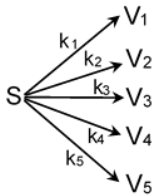
curve at half maximum, mass fractions, Y peak , and rates of mass loss, ( − dY/dt) peak , in correspondence to the peak rate and mass fraction at a temperature of 773 K (char yield), Y 773